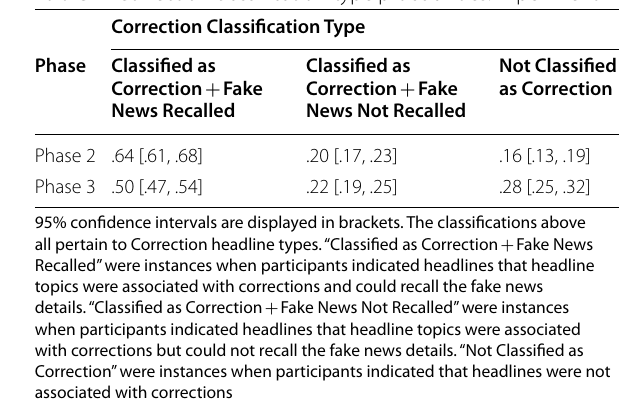
95% confidence intervals are displayed in brackets